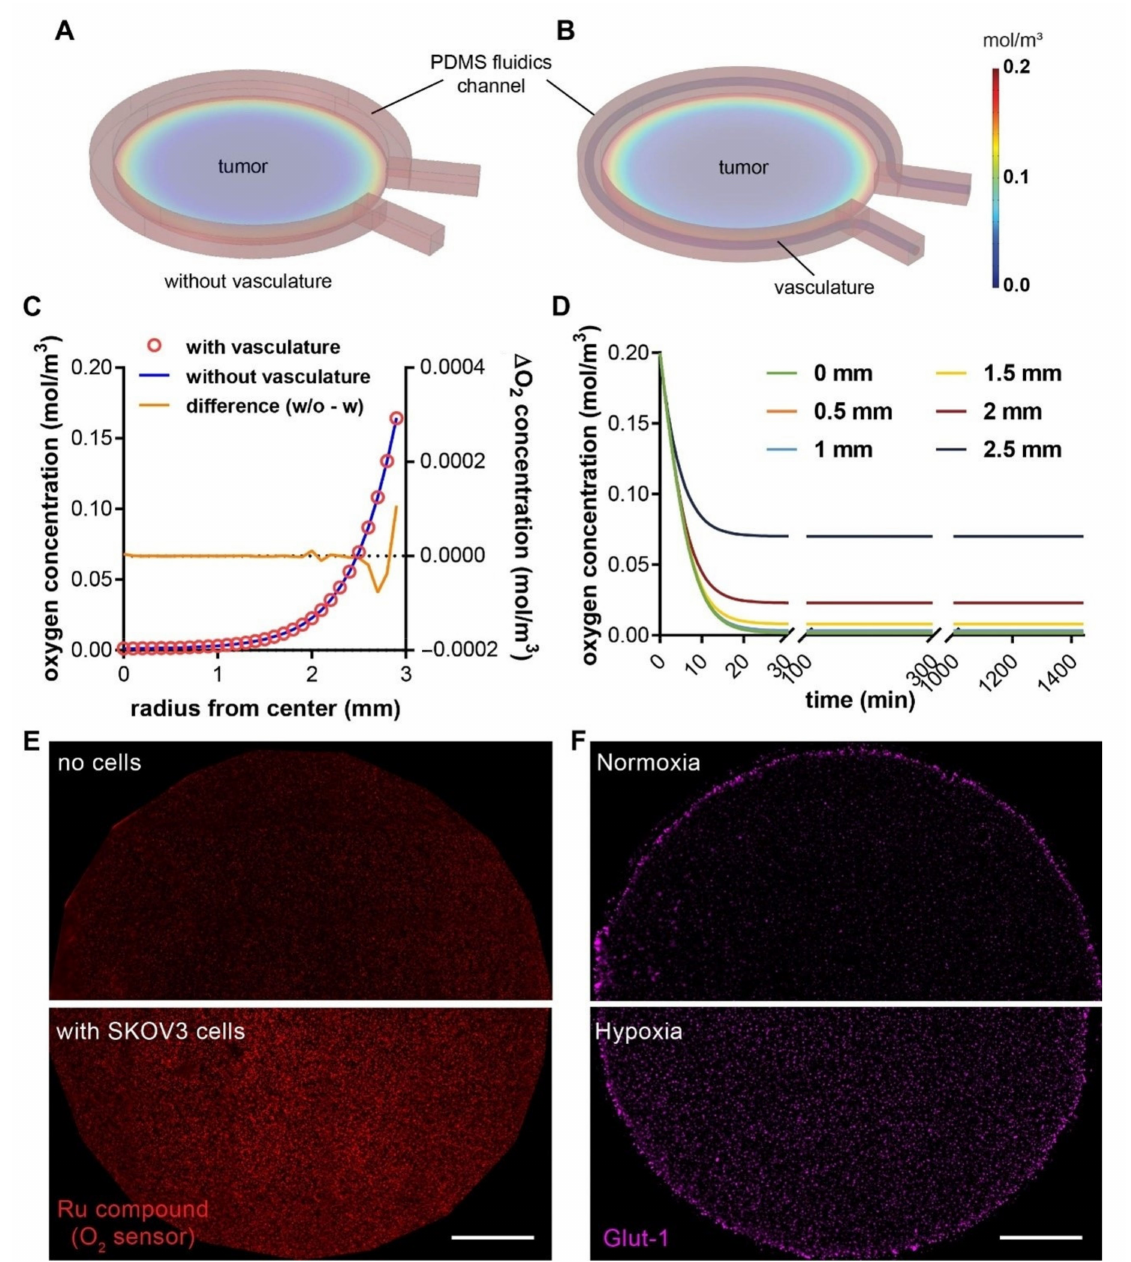
Figure 4. COMSOL simulation of oxygen profiles in hypoxic tumor models without or with the vascular channel. Oxygen profile in ( A ) a tumor model with microfluidic channel alone, and ( B ) a composite vascularized hypoxic tumor model. ( C ) Radial distribution of oxygen concentrations from the center to the edge of the tumor region without (blue line; the left y-axis) or with vasculature (red circles; the left y-axis), and the difference between the two (orange line; the right y-axis). ( D ) Rapid achievement of the steady-state oxygen levels at different radial positions in the vascularized tumor model. Model dimensions are the same as the actual sizes. ( E ) Measurement of oxygen levels in the tumor section without ( top ) or with ( bottom ) SKOV3 cancer cells at 24 h, using an oxygen-sensitive ruthenium compound absorbed in silica microparticles and embedded in a thin layer of PDMS on the PC pillar. Higher fluorescence indicates lower oxygen level. ( F ) The expression of Glut-1, a hypoxic marker, in the embedded SKOV3 cancer cells in the tumor section in normoxia ( top , hypoxia model removed of the PC cap on day 0) vs. hypoxia ( bottom ) model after 24 h of culture. Scale bars: 1